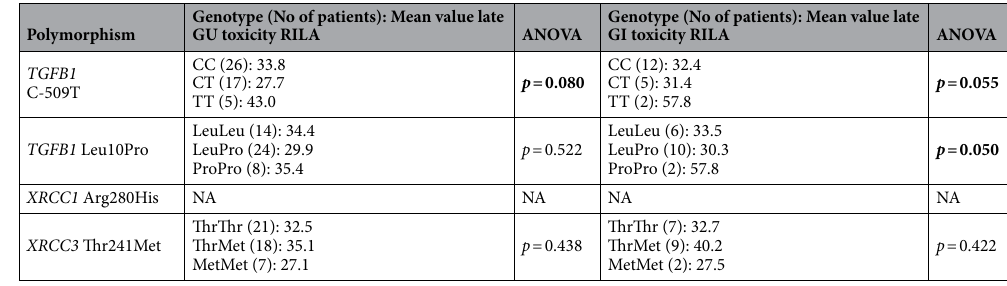
Table 5. Association of polymorphic variants with RILA values. NA- not applicable. Bolded values indicate statistically significant data or statistical trend. GU- genitourinary; GI- gastrointestinal.